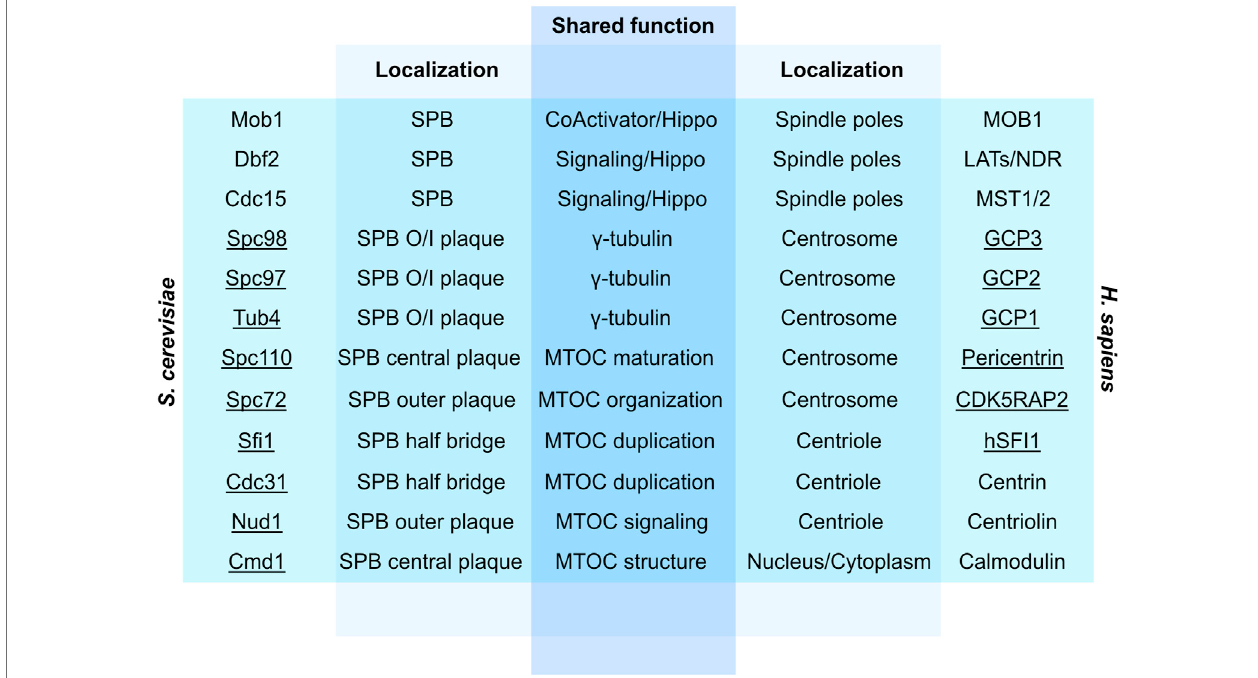
Frontiers in Cell and Developmental Biology |